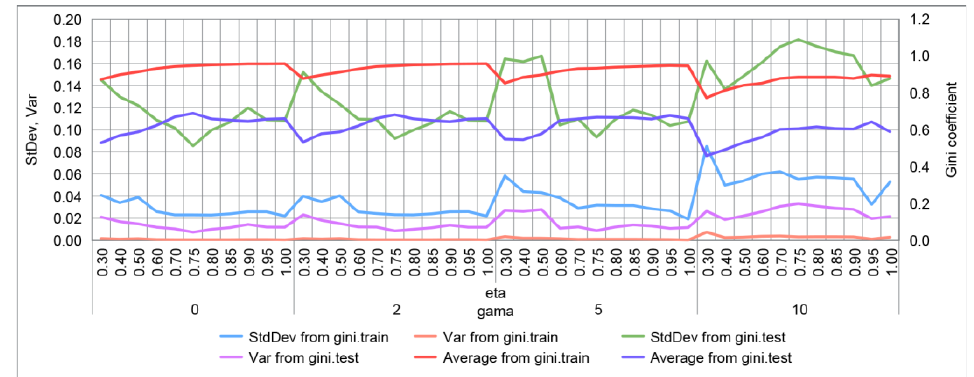
Figure 3. Discriminant power and stability of the XGB model with regard to changes in gamma and eta parameters.